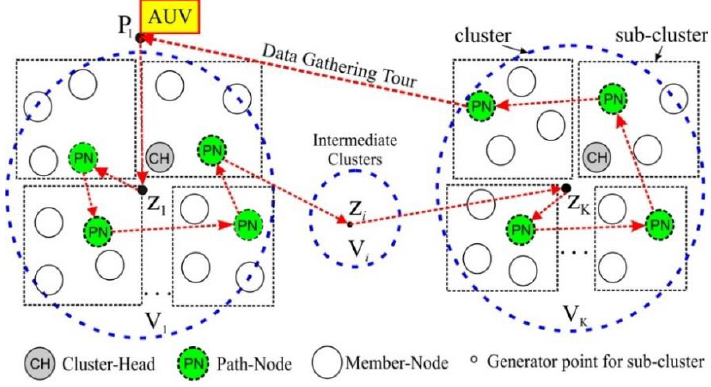
Figure 5. AUV data-gathering tour in UWSN.